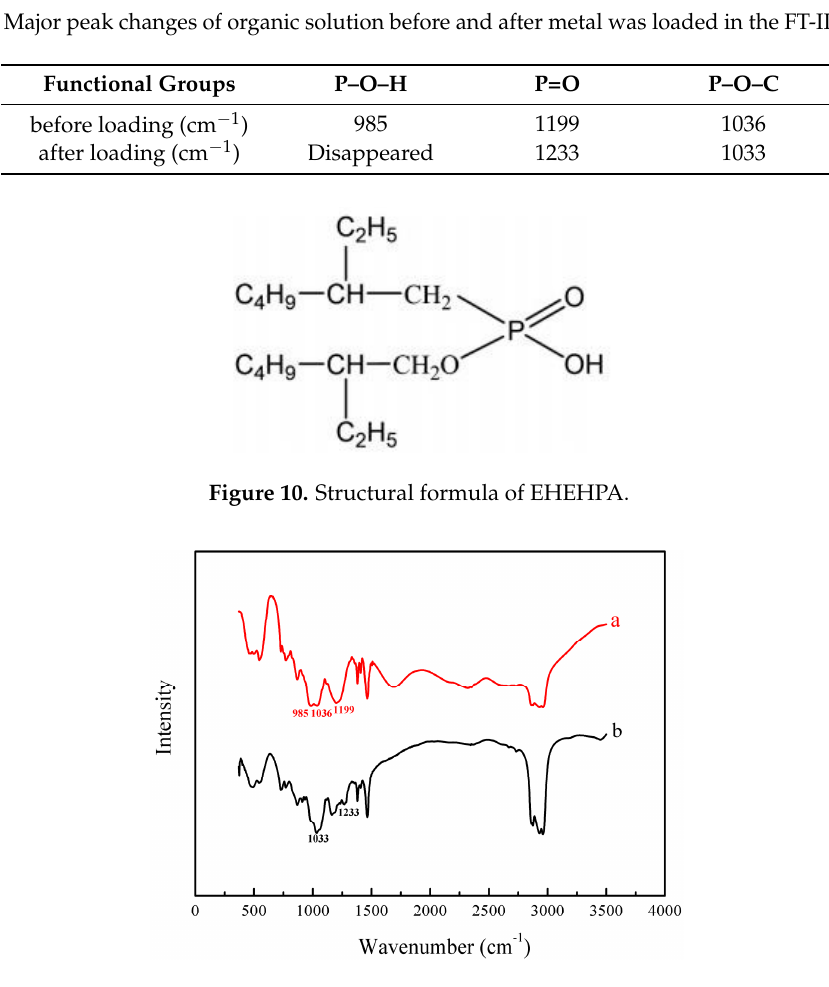
Figure 11. FT ‐ IR spectra of ( a ) EHEHPA and ( b ) metal ions loaded with EHEHPA.